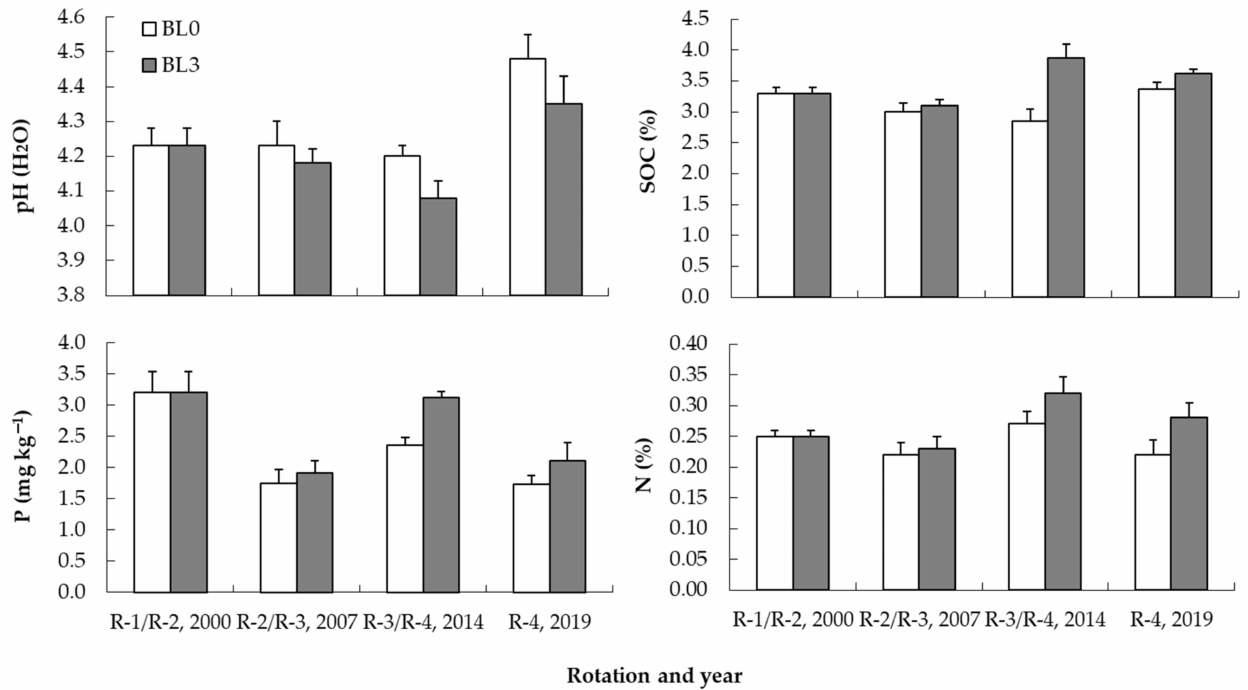
Figure 4. Changes in 0–10 cm soil layer: pH, organic carbon (SOC), extractable P, and total N in from the end of the first rotation (R-1/R-2) to the end of fourth rotation (R-4). Vertical bars are SEs. R-1 to R-3 Acacia mangium , and R-4 Eucalyptus pellita